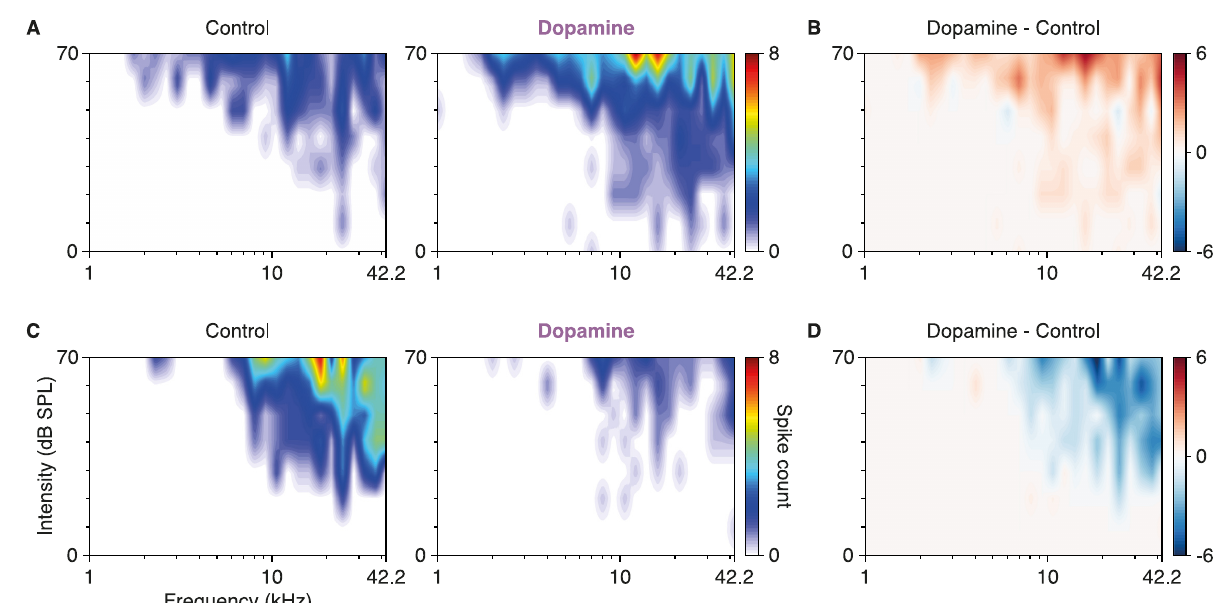
Fig 2. Dopamine effects on the FRA. (A) FRA of a neuron in control condition (left panel) and after dopamine application (right panel). (B) The subtraction of the control FRA from the FRA after dopamine application reveals that dopamine increased the excitability of this unit. (C) FRA of another neuron in control condition (left panel) and after dopamine application (right panel). (D) The subtraction of the control FRA from that after dopamine application in (C) reveals that dopamine decreased the excitability of this neuron. The underlying data for this figure can be found in S1 Data. dB SPL, decibels of sound pressure level; FRA, frequency response area